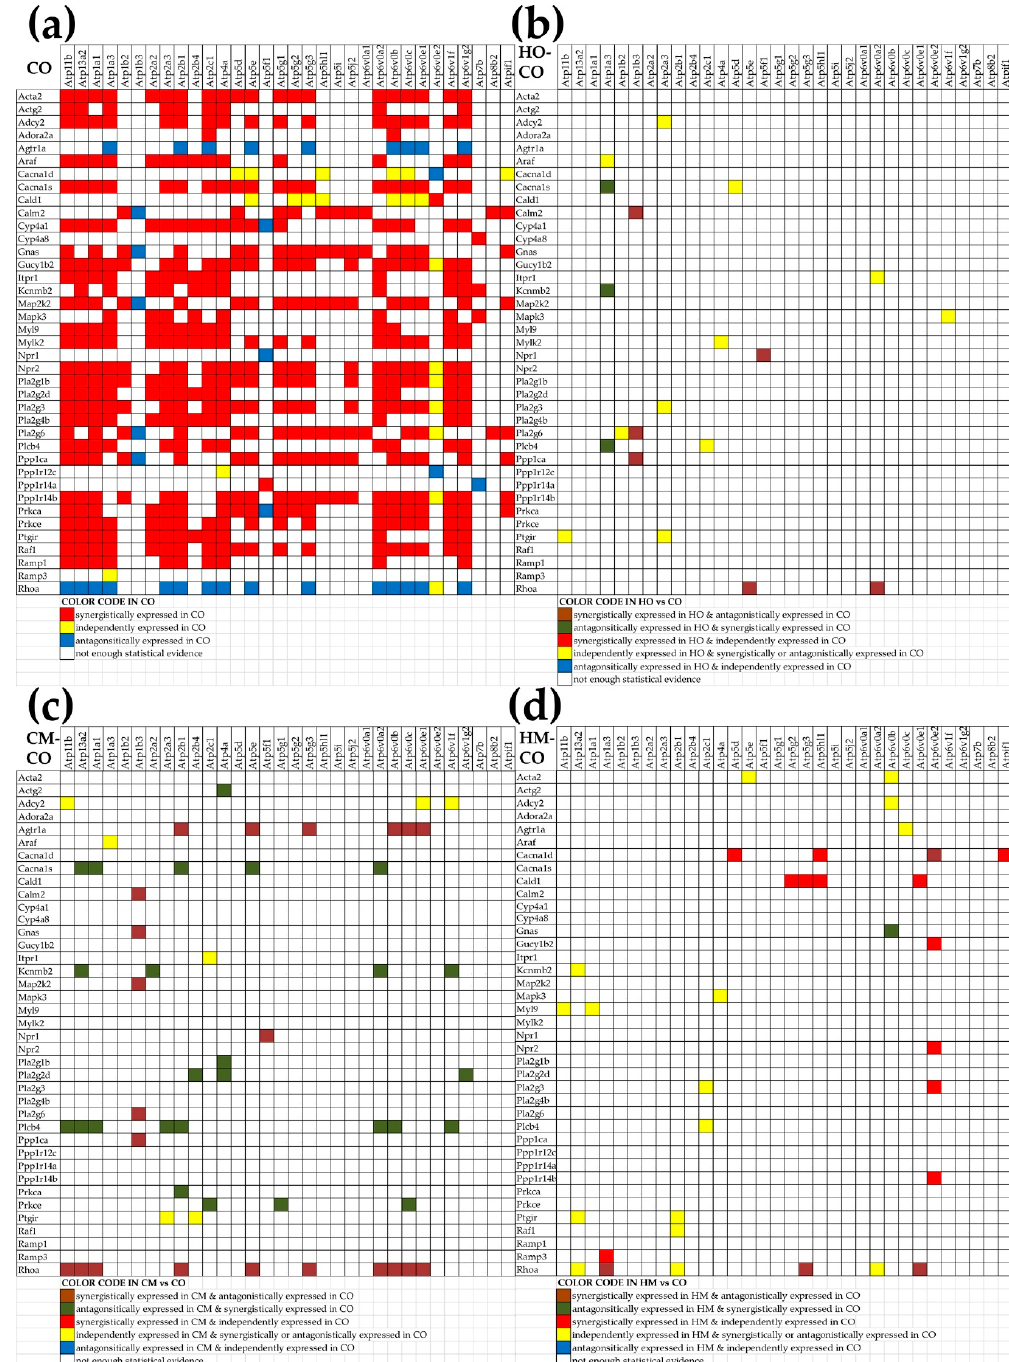
Figure 5. Synergistically (red squares), antagonistically (blue squares), and independently (yellow squares) expressed pairs of VSMC genes and ATPases in CO ( a ) whose expression correlation was significantly altered by hypoxia ( b ), monocrotaline ( c ), or the combined action of hypoxia and monocrotaline ( d ). A blank square in ( a ) indicates that the correlation is not ( p < 0.05) statistically significant.